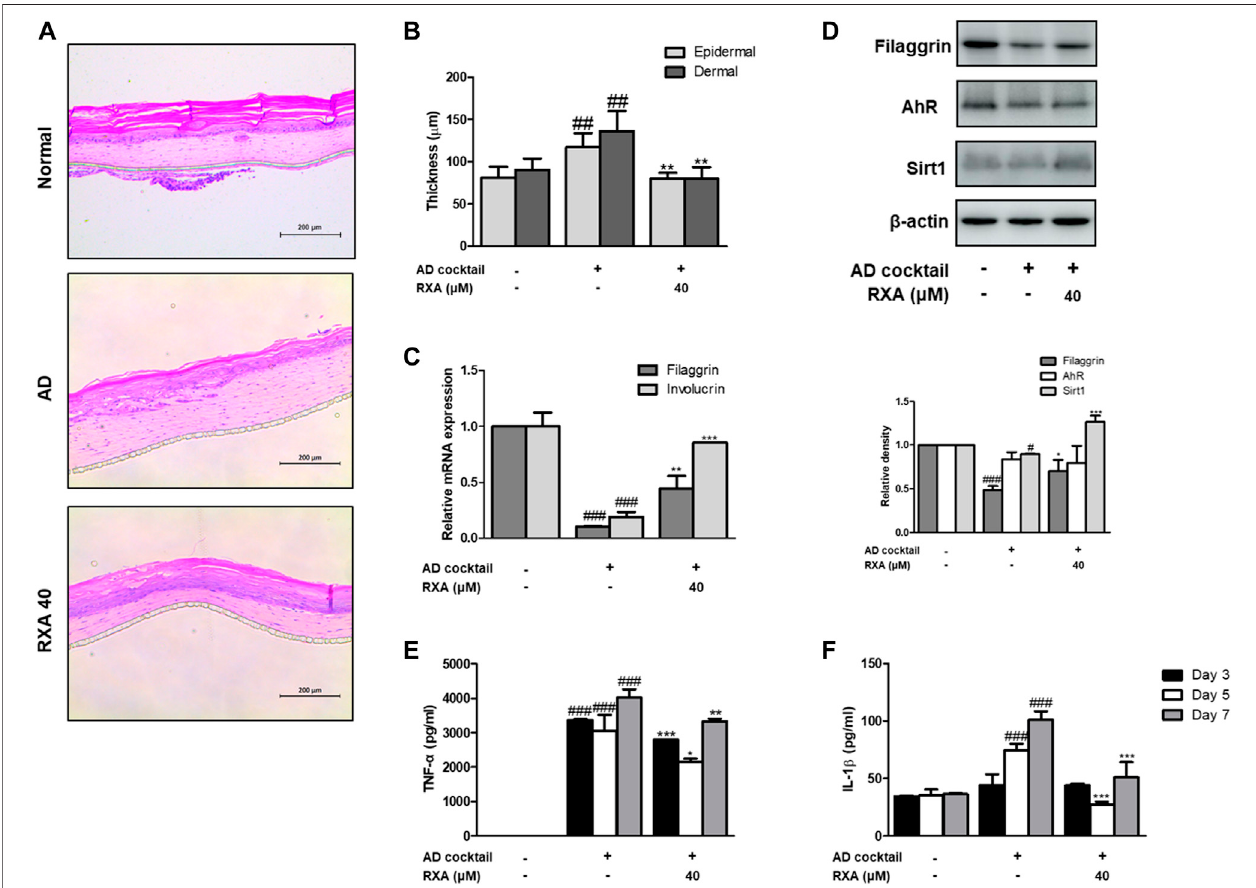
FIGURE 7 | Effects of RXA on the AD-like HSE model. (A) Histological features of the AD-like HSE model. Tissues were excised, fi xed in 10% formaldehyde, embedded in paraf fi n, and sectioned. The sections were stained with H&E. Blue bar indicates epidermis. (B) Epidermal and dermal thickness in H&E stained sections were measured under a microscope. (C) The mRNA levels of fi laggrin and involucrin were determined by qRT-PCR. (D) Total proteins were prepared and analyzed by Westernblottingtechnique for fi laggrin,AhR,and SIRT1,usingspeci fi cantibodies. β -actinwasused astheinternalcontrol.Theproductionof (E) TNF- α and (F) IL- 1 β was measured at day 3, 5, 7 by ELISA. The data shown represent mean ± S.D. of three independent experiments ( n (cid:1) 3). # p < 0.05, ## p < 0.01, ### p < 0.001 vs. the control group; * p < 0.05, ** p < 0.01, and *** p < 0.001 vs. AD cocktail-treated group.